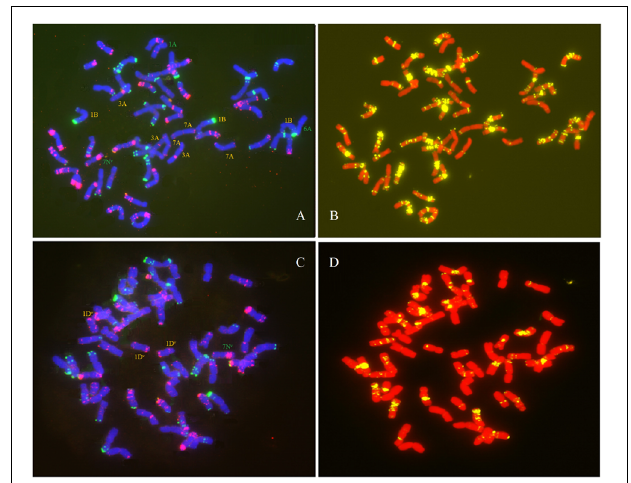
FIGURE 7 | FISH analysis of two types of “hidden aneuploidy” using Oligo-pSc119.2 (green), Oligo-pTa535 (red) and Oligo-(GAA) 7 (yellow)